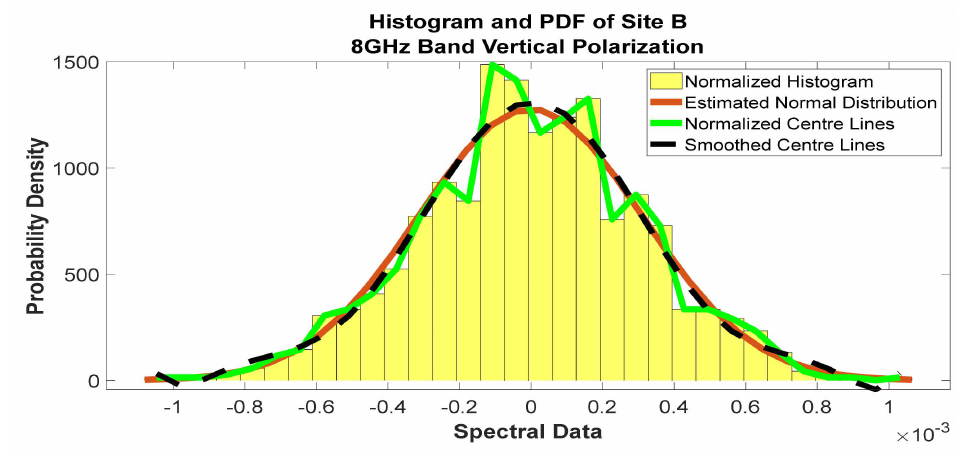
Figure 32. Histogram and PDF of the frequency scan for site B at 8 GHz vertical